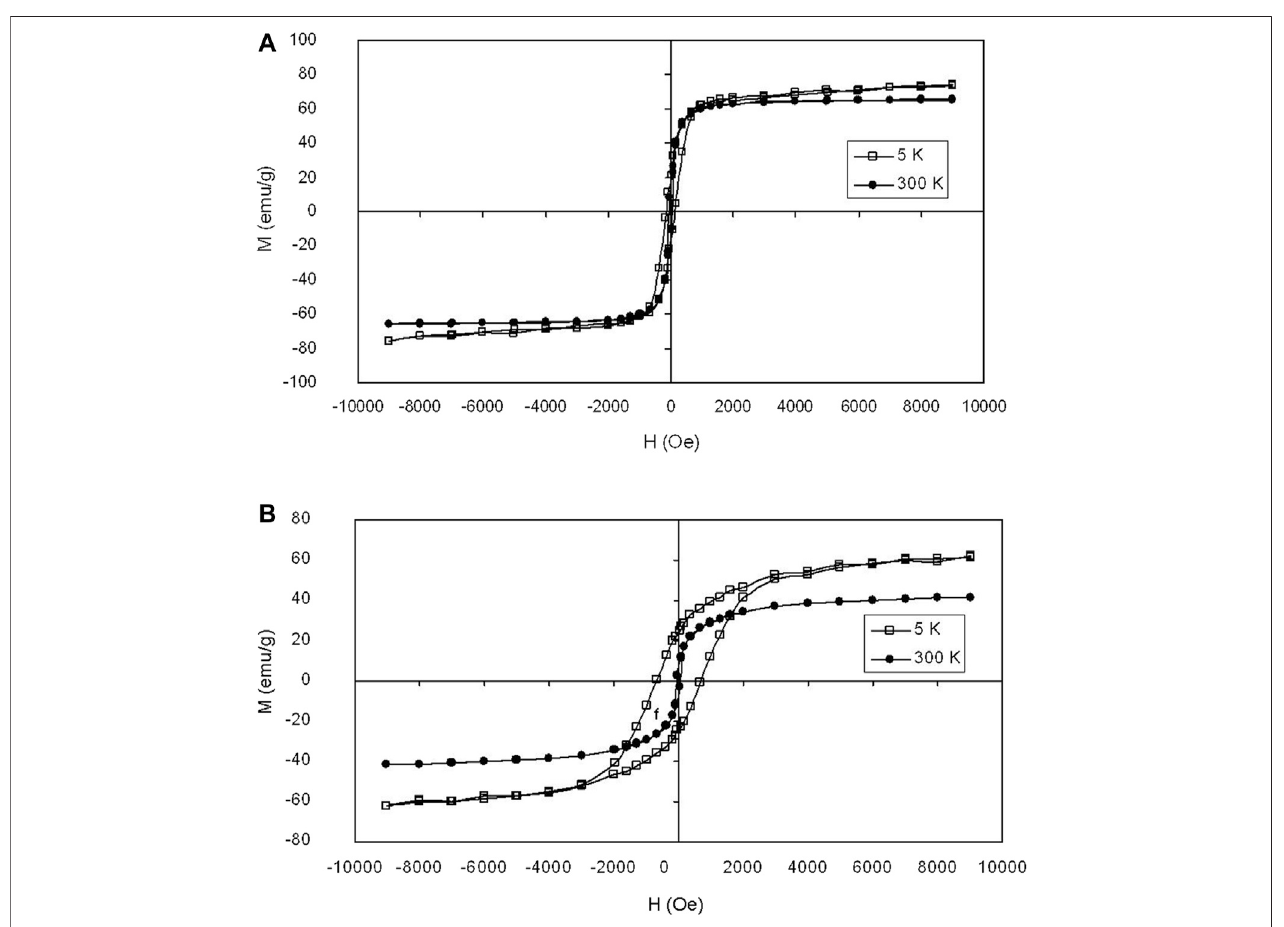
FIGURE6| Magnetizationloopsof (A) ironoxideatsilicacore/shellnanoparticleswith16.2 nmcoreand (B) ironnitrideatsilicacore/shellnanoparticlestransferred (cid:129) from (A) measured at □ ) 5 K and ) 300 K, respectively.